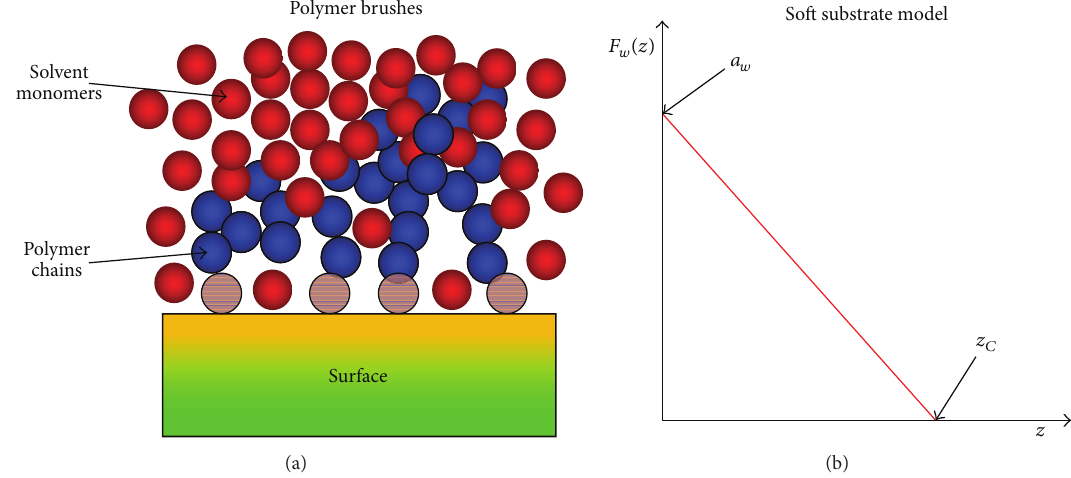
Figure 9: (a) Model for polymer brushes grafted on a substrate. (b) A simple model for the soft surface effective interaction with the rest of the fluid; 𝑎 𝑤 is the magnitude of the interaction and 𝑧 𝐶 is the cutoff distance, beyond which the surface interaction vanishes; see (13).